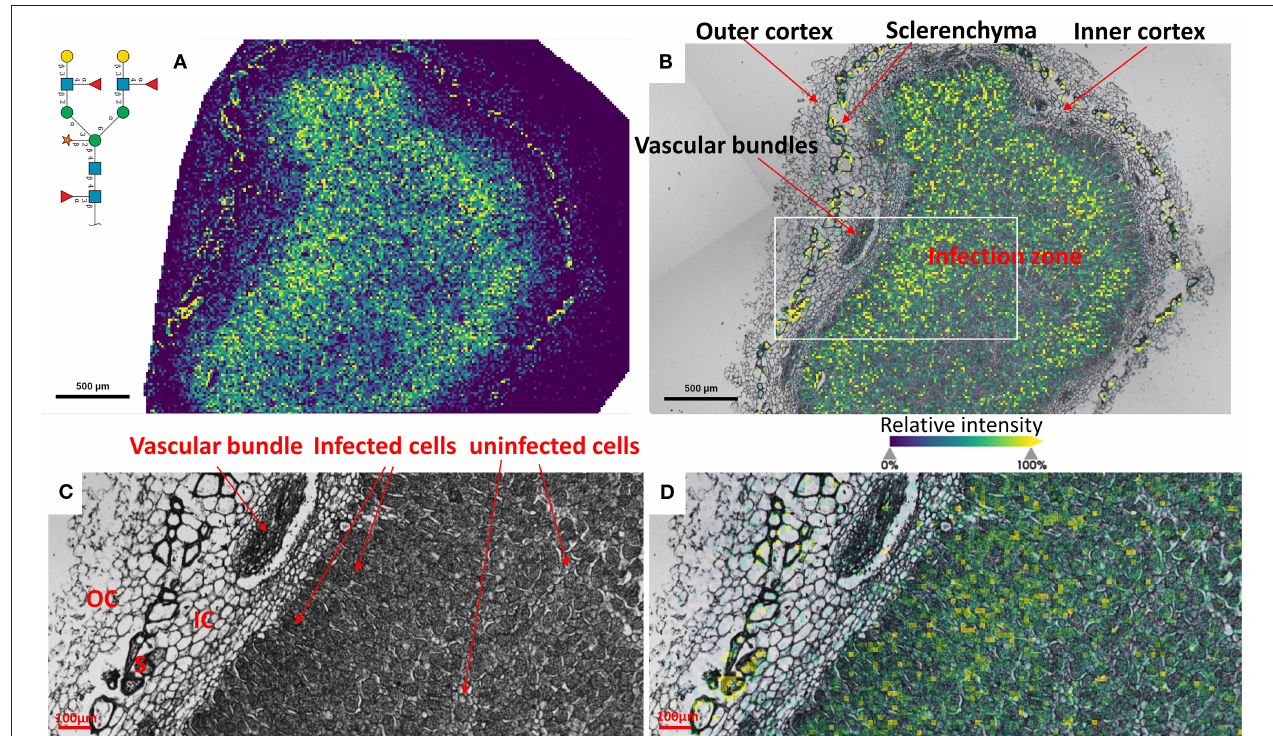
FIGURE 5 | (A) Spatial pattern of Hex:5 HexNAc:4 dHex:3 Pent:1 glycan in WT nodule at 15 µ m spatial resolution. (B) Morphologically and functionally different cell types and layers inside soybean root nodules are annotated. A white rectangle denotes an area that is enlarged on (C,D) for fine visualization of distinct cell types. (C,D) Zoomed areas inside the infection zone with annotated infected (dark, large cells) and uninfected cells (small light cells) show a higher abundance of N -glycans in the dense population of infected cells not interrupted by uninfected cells. Outer cortex (OC), inner cortex (IC), and sclerenchyma cells (S) are also annotated. The scale bar at (A,B) is 500 µ m and at (C,D) is 100 µ m. Interactive display of N -glycans composition, structure, spatial localization and colocalization with specific cell types can be further browsed, visualized, and explored using the METASPACE link: